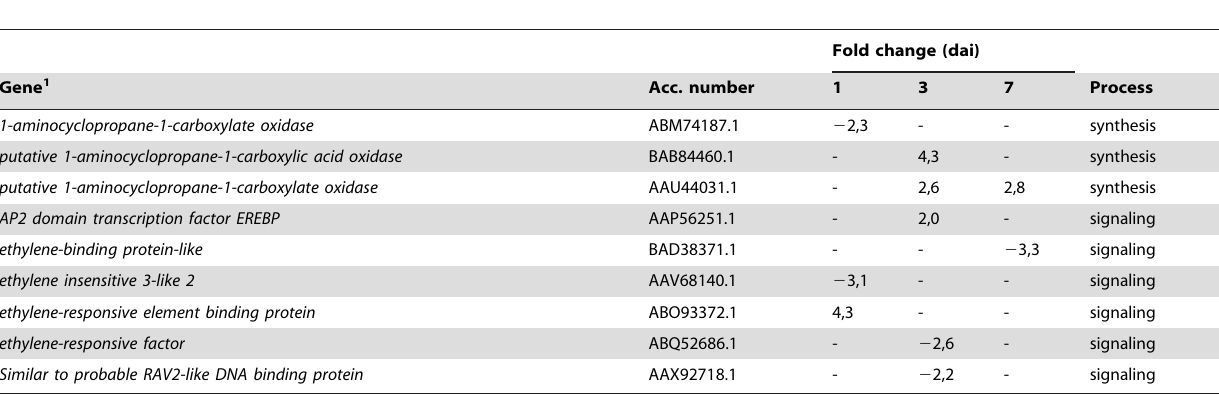
Table 1. List of barley genes differentially regulated by P. indica and involved in ethylene synthesis or signaling.